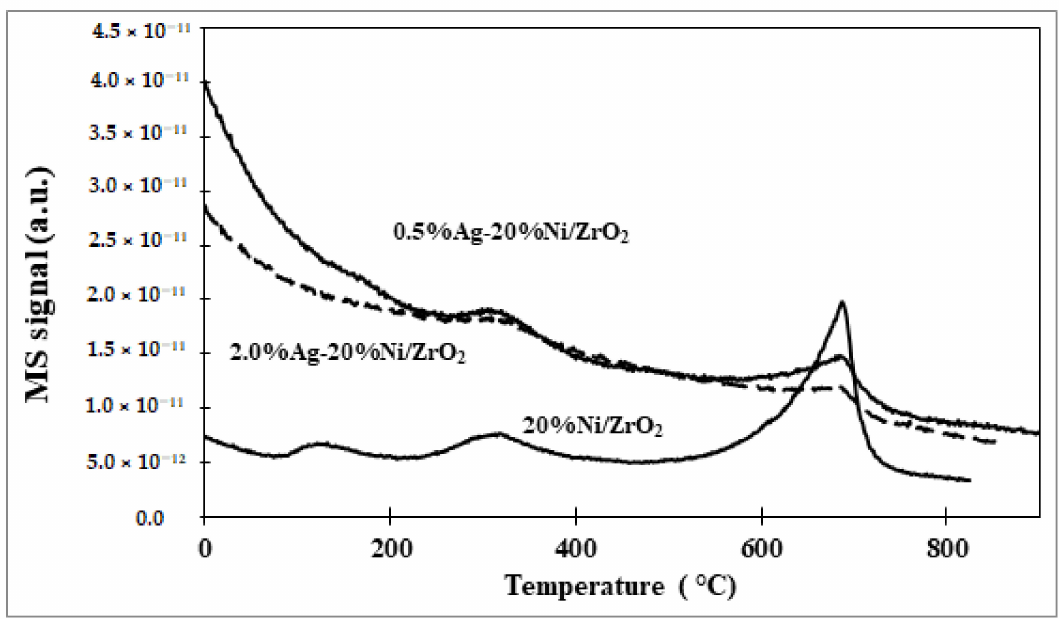
Figure 15. MS profiles for m / z = 44 (CO 2 ) obtained during the thermal analysis performed in an air atmosphere of the spent catalysts in OSR of LNG process (after 12 h of the